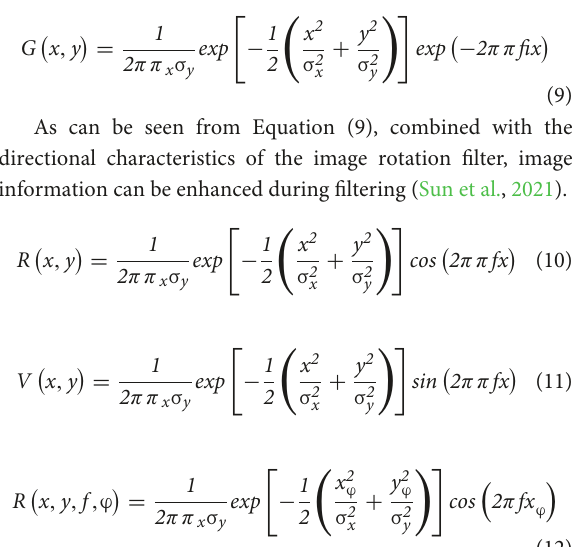
FIGURE10 Pixel values of flames in different channels: (A) Flame pixel value of Y channel, (B) flame pixel value of Cb channel, and (C) flame pixel value of Cr